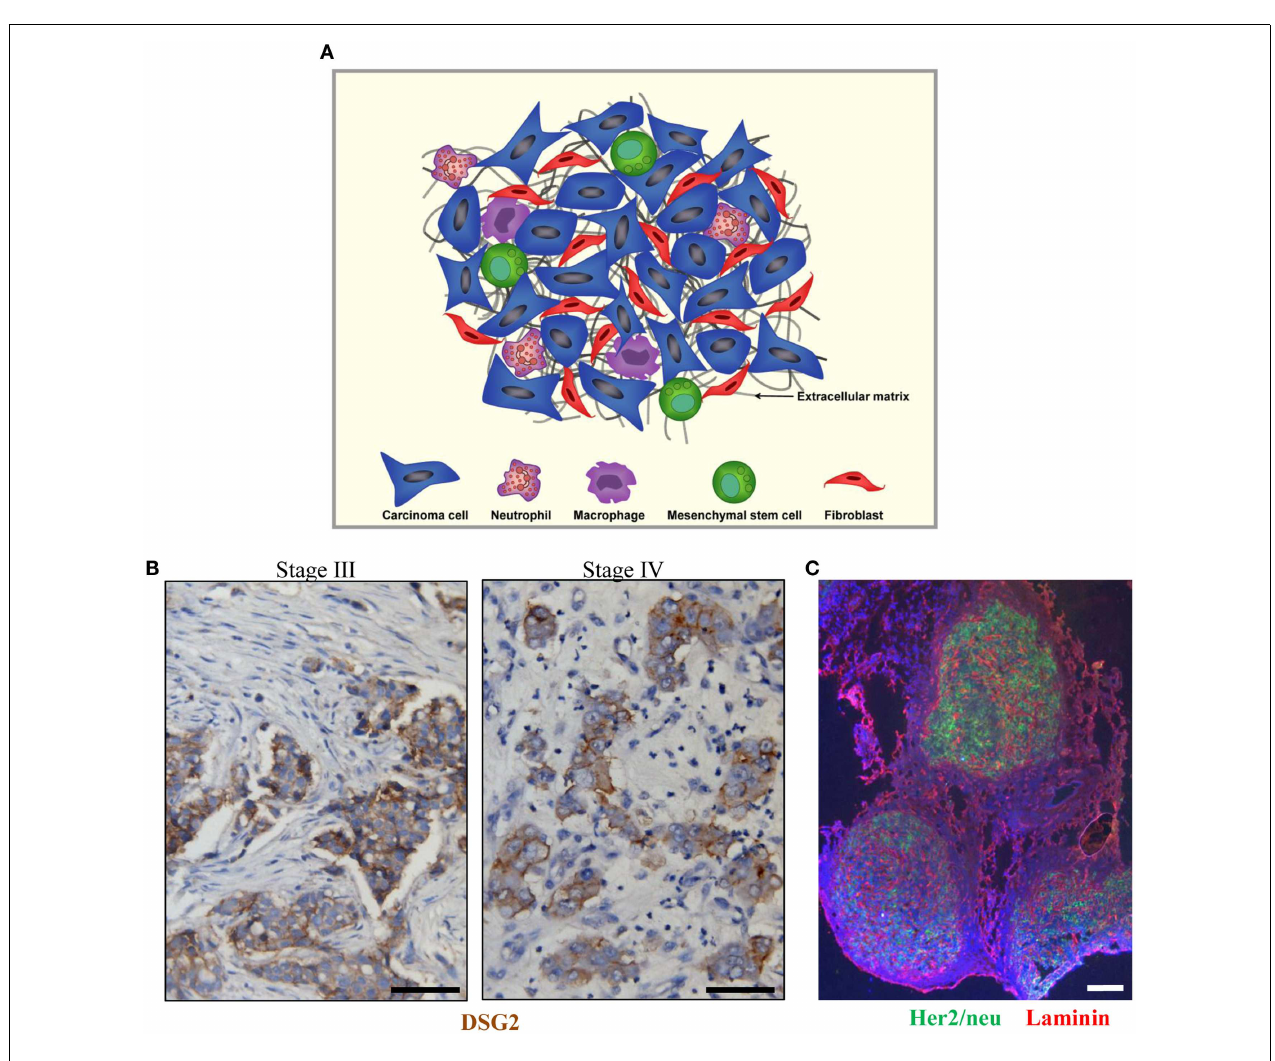
Malignant cells are DSG2-positive and form nests that are surrounded by tumor stroma containing DSG2-negative stroma cells such as fibroblasts. (C) Immunofluorescence analysis for Her2/neu (green) and the stroma protein laminin (red) on a breast cancer section.The scale bar is 20 µ